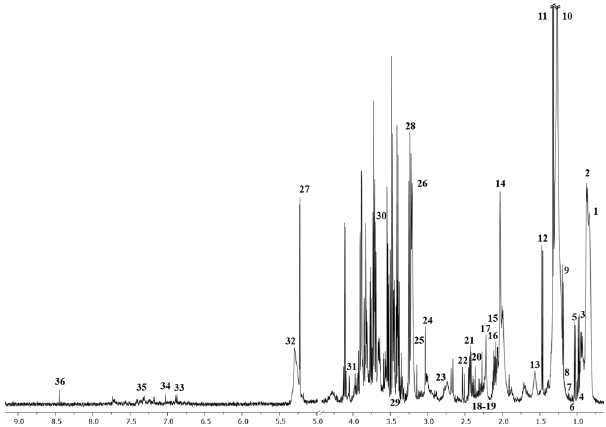
Figure 1. The representative spectrum 1 H NMR obtained from serum samples of HC subjects. The following metabolites are identified: 1, L_1; 2, L_2; 3, Isoleucine; 4, Leucine; 5, Valine; 6, Unk_1; 7, 3-Hydroxybutyrate; 8, L_3; 9, L_4; 10, L_5; 11, Lactate; 12, Alanine; 13, L_6; 14, Acetate; 15, L_7; 16, L_8; 17, NAC; 18, Acetone; 19, Acetoacetate; 20, Pyruvate; 21, Glutamine; 22, Citrate; 23, Unk_2; 24, Creatine; 25, Dimethyl sulfone; 26, Chol + GPC + APC; 27, Glucose; 28, Betaine; 29, Methanol; 30, Glycerol; 31, Creatinine; 32, L_9; 33, Tyrosine; 34, π -Methylhistidine; 35, Phenylalanine; 36, Formate.